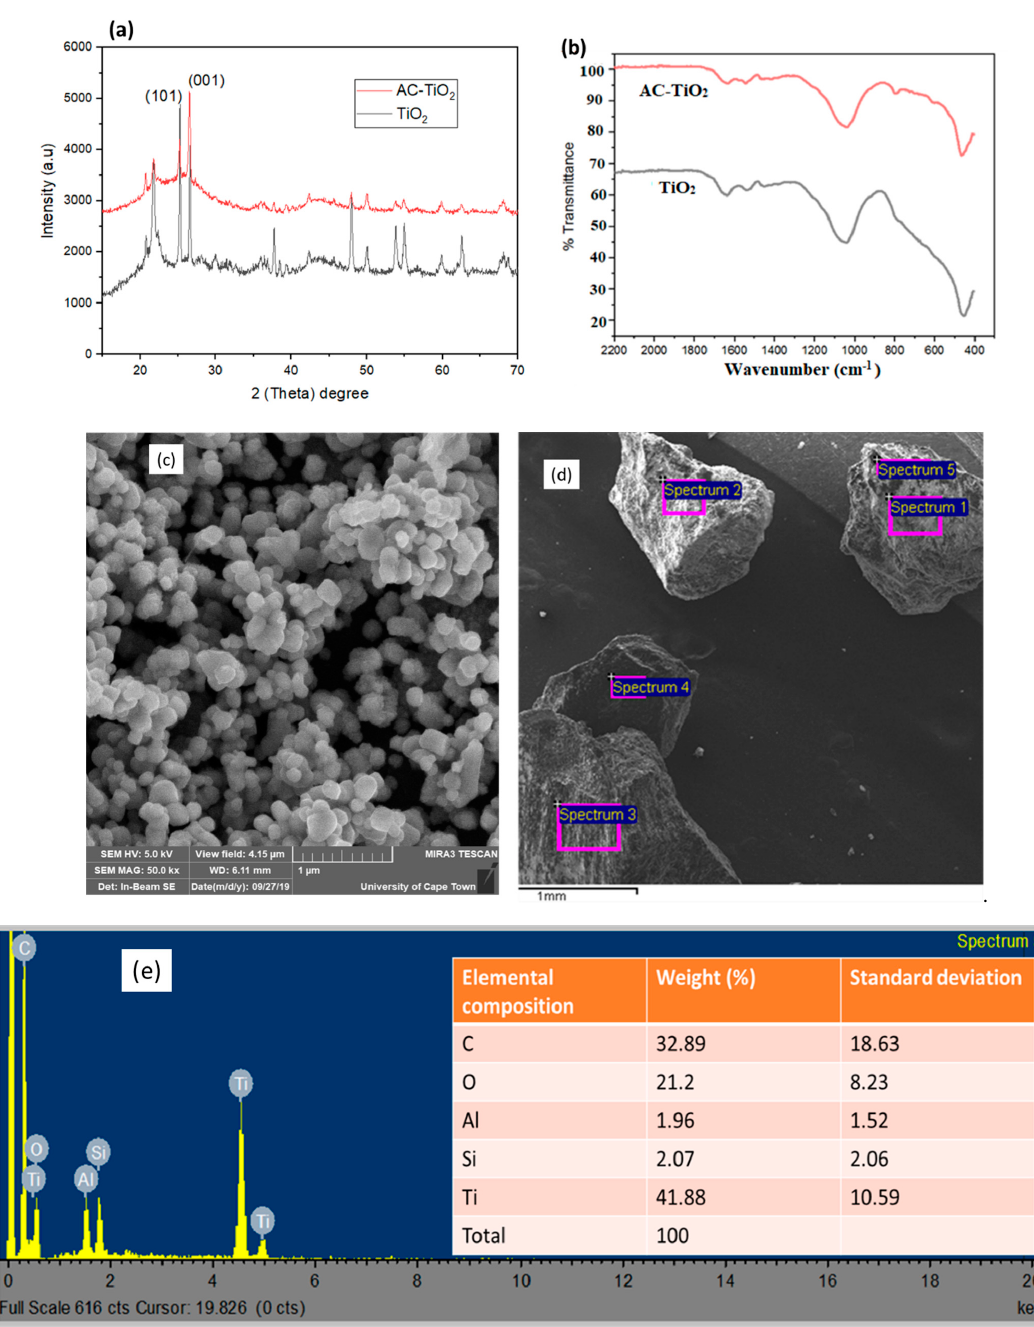
Figure 2. Spectra of ( a ) XRD and ( b ) FTIR analysis for TiO 2 (black) and AC ‐ TiO 2 (red); ( c ) SEM and ( d ) EDX image of AC ‐ TiO 2 and ( e ) EDX spectra and elemental composition of AC ‐ TiO 2.